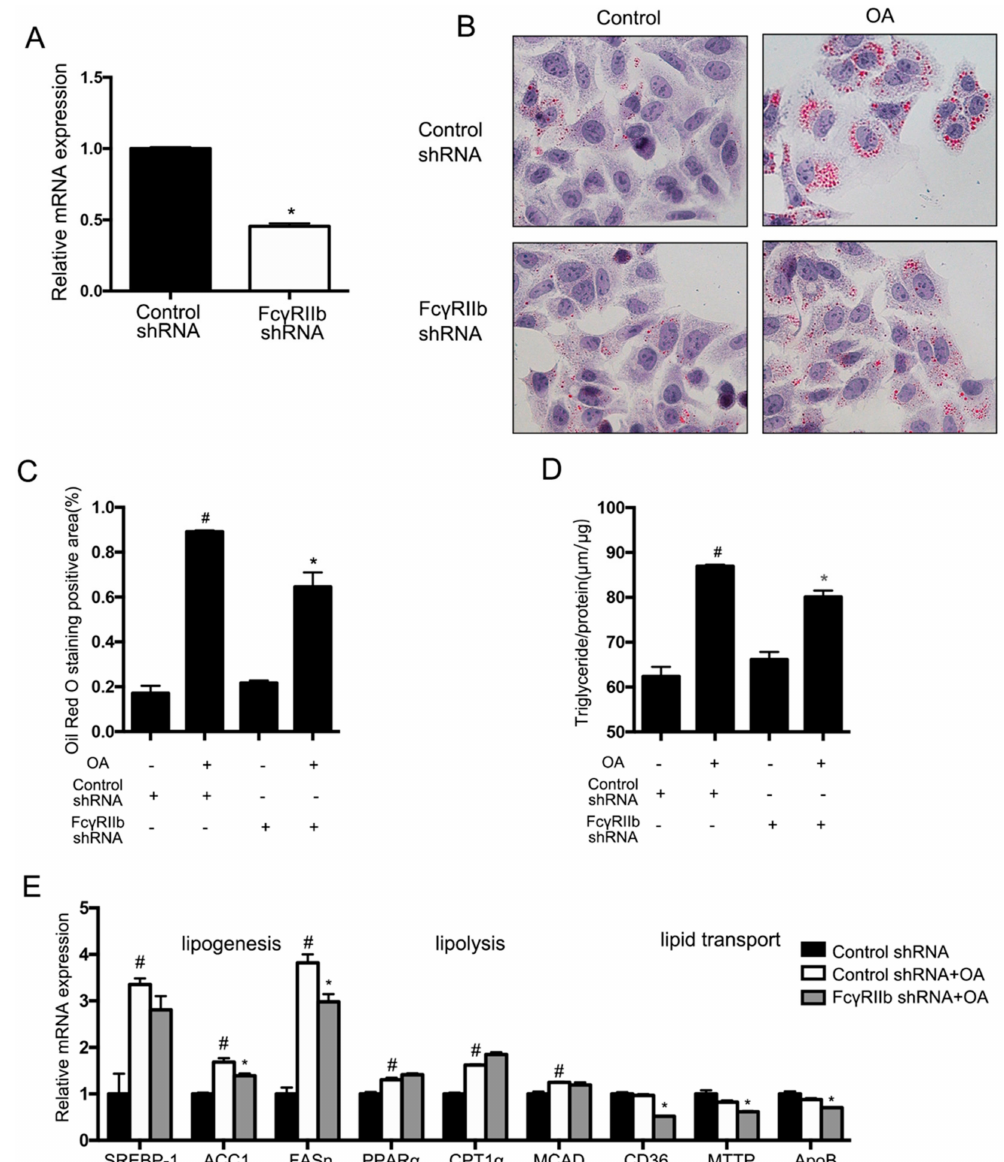
Figure 3. Effect of Fc γ RIIb knockdown on lipid accumulation in OA induced steatosis. ( A ) Relative mRNA expression of Fc γ RIIb in HepG2 48 h after Fc γ RIIb-shRNA and Control-shRNA administration. ( B ) Oil Red O staining (40 × ) for lipid droplets in HepG2 after 24 h OA treatment. ( C ) Statistical analysis of Oil Red O staining positive areas. * p < 0.05, between control-shRNA and Fc γ RIIb-shRNA treatment under OA, # p < 0.05, between basal and OA treament in control-shRNA. ( D ) Measurement of intracellular triglyceride content in HepG2. * p < 0.05, between control-shRNA and Fc γ RIIb-shRNA treatment under OA, # p < 0.05, between basal and OA treatment in control-shRNA transfected. ( E ) Relative mRNA expression of the genes involved in lipid synthesis, β -oxidation, and lipid transportation in control cell of basal level, knockdown, and control HepG2 after OA treatment. Gene expression was normalized to that of β -actin. The data shown are the means ± SEM. # p < 0.05, between control shRNA cell with and without OA treatment (bar 1 and bar 2); * p < 0.05, between control and Fc γ RIIb shRNA with OA treatment (bar 2 and bar